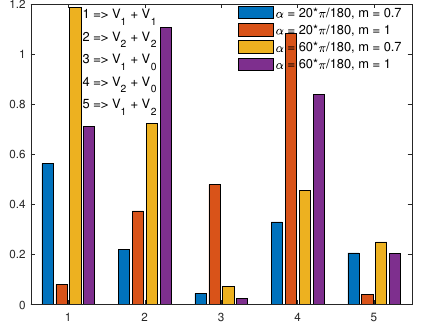
Figure 6. Capacitor RMS current depiction for space vector mutual